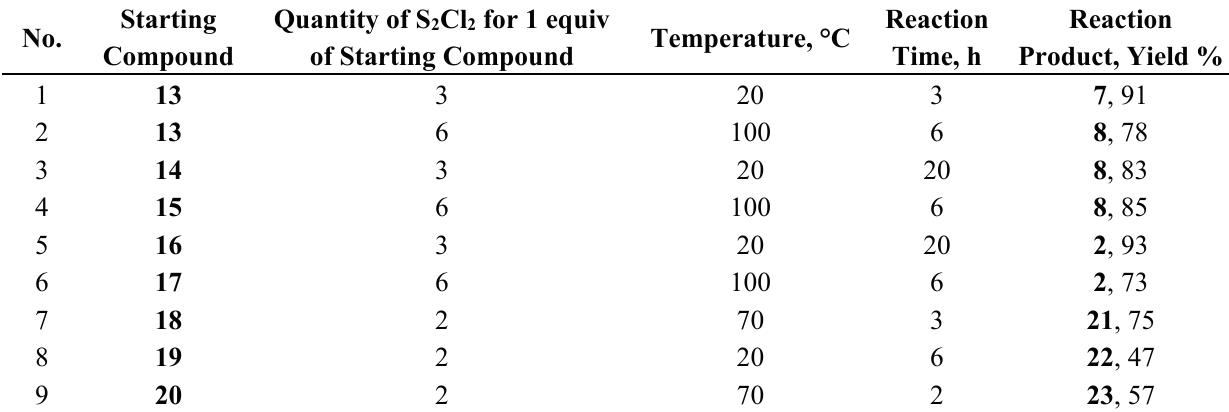
Table 2. Reactions of fused 1,2,5-selenadiazoles with S 2 Cl 2 in